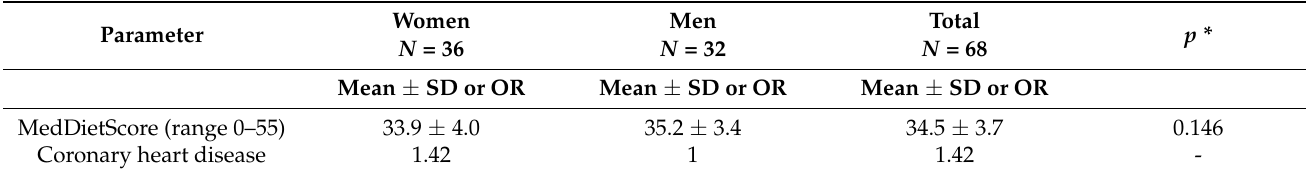
Table 2. Results of the Mediterranean Islands study food frequency questionnaire (MEDIS-FFQ). Parameter